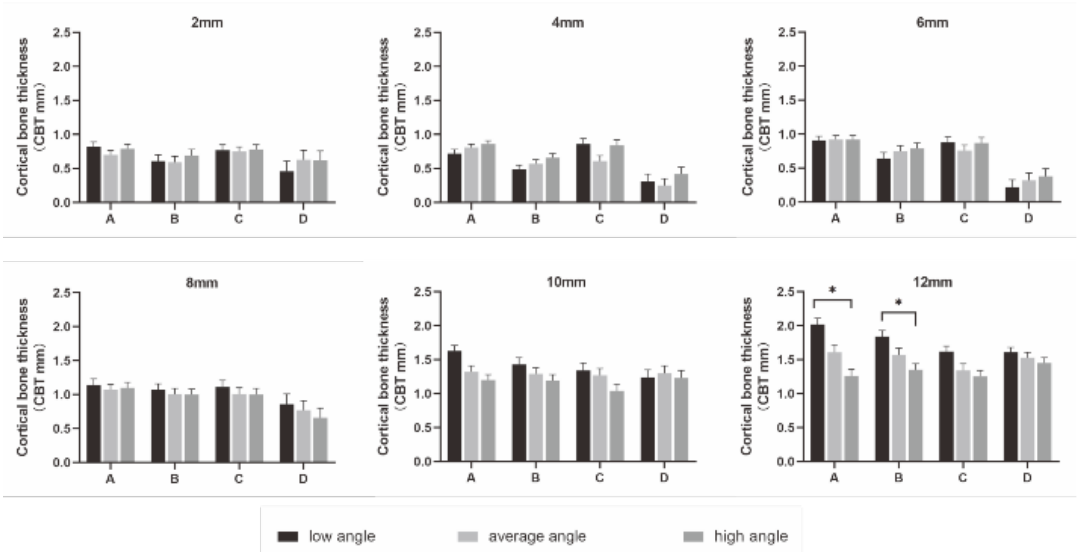
Figure 3. Comparisons of CBT among different facial types at each location. * p < 0.05.